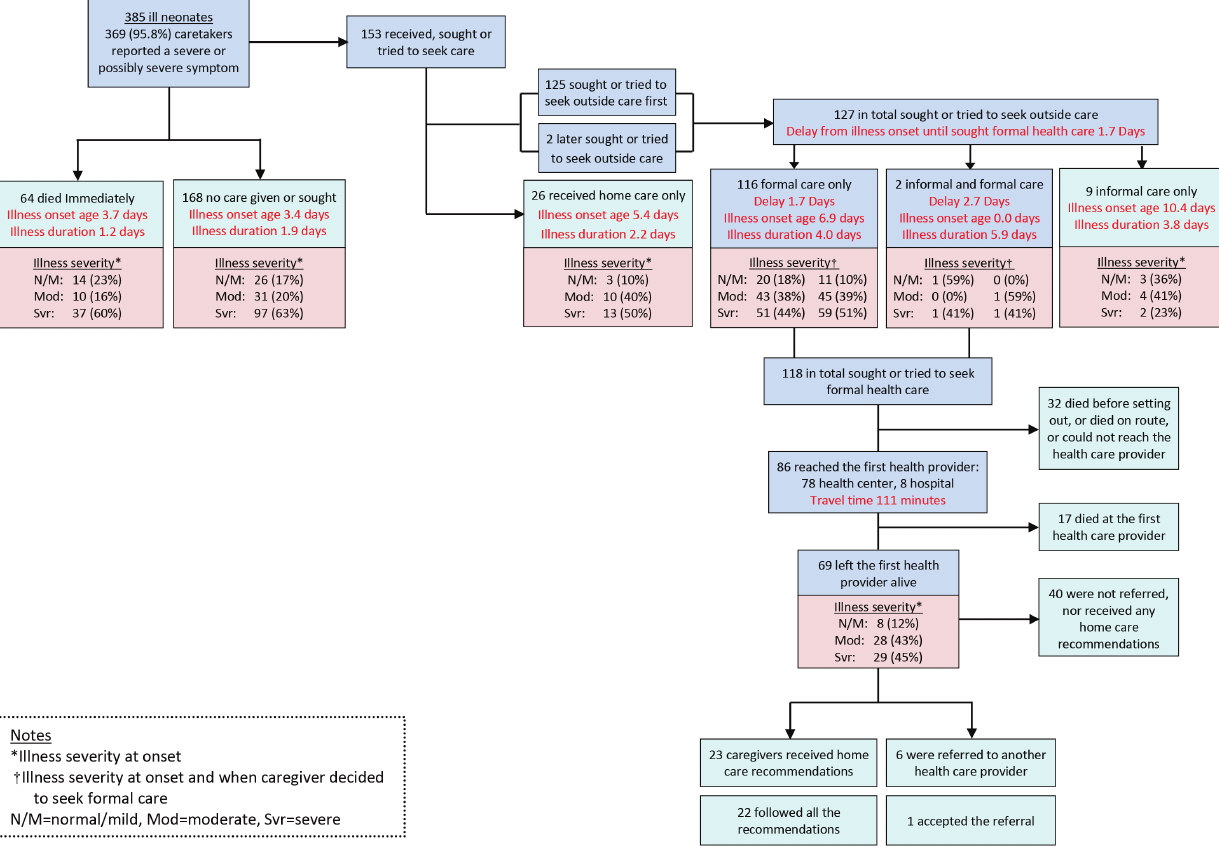
Figure 3. The “Pathway to Survival” for 385 neonatal deaths born at home or left the delivery facility alive, Niger 2007–2010.